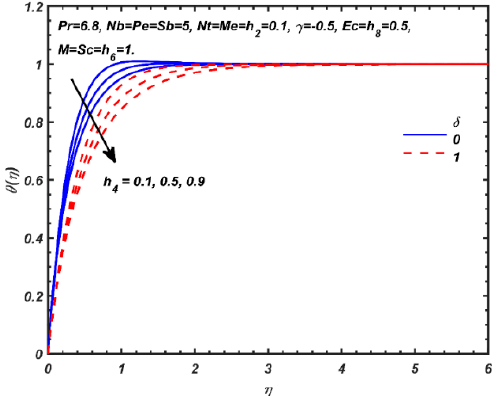
ff ects h δ on the dimensionless 4 and Figure 3. Effects Figure 3. E